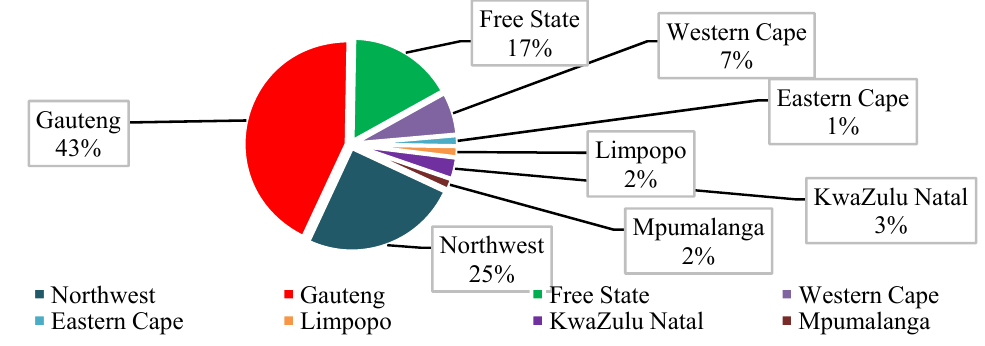
Fig. 1. Participant geographic demographics